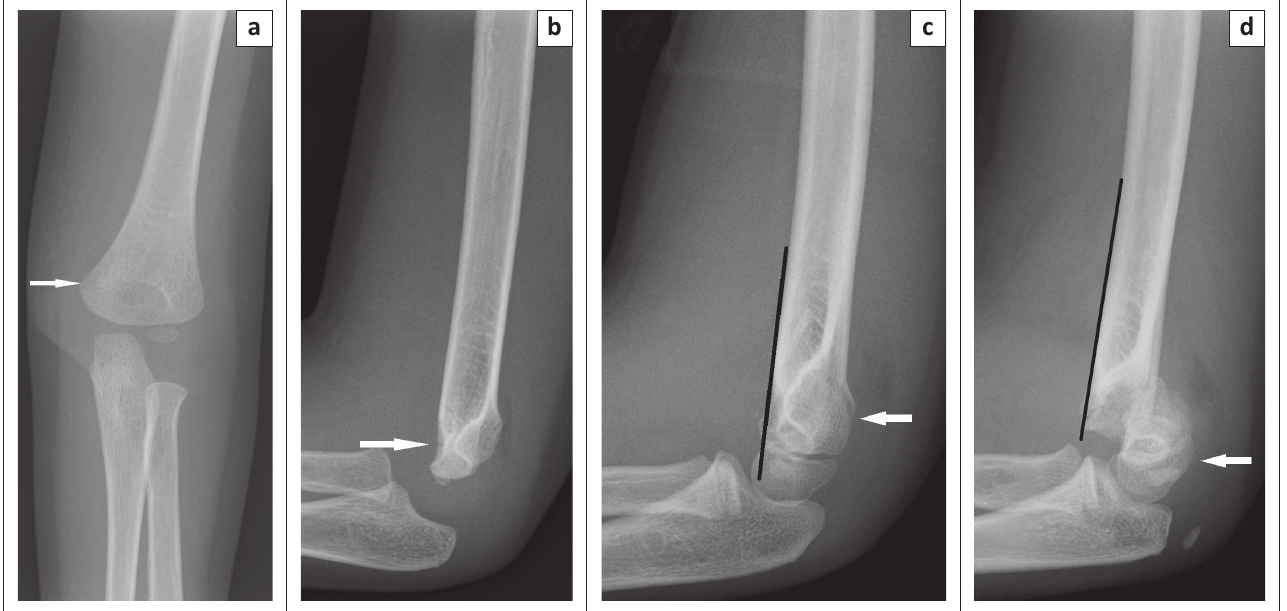
FIGURE 7: Type 1 supracondylar fracture on (a) AP and (b) lateral (arrow) with positive posterior fat pad and intact posterior cortex. Note with the incompletely ossified capitellum that one cannot use the anterior humeral line to assess alignment. (c) Type 2 supracondylar fracture showing posteriorly displaced fragment as evidenced by abnormal anterior humeral line (black line), although fracture is visible, posterior cortex is intact(white arrow) and positive posterior fat pad. (d) Type 3 supracondylar fracture with displaced fragment (arrow), discontinuous anterior humeral line (black line) and posterior fat